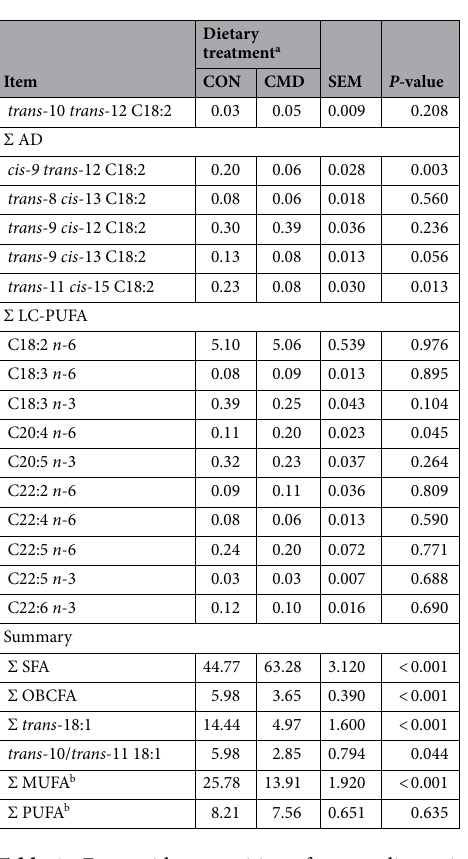
Table 4. Fatty acid composition of rumen digesta in lambs fed concentrate diets containing dehydrated lucerne (CON) or cardoon meal (CMD). SEM pooled standard error of the mean, SFA saturated fatty acids, OBCFA odd-and branched-chain fatty acids, MUFA monounsaturated fatty acids, CLA conjugated linoleic acids, AD atypical dienoic fatty acids, PUFA polyunsaturated fatty acids, LC-PUFA long-chain polyunsaturated fatty acids. a CON control diet, CMD cardoon meal diet. b Σ MUFA = Σ cis -MUFA + Σ trans -18:1; Σ PUFA = Σ CLA + Σ AD + Σ LC - PUFA.